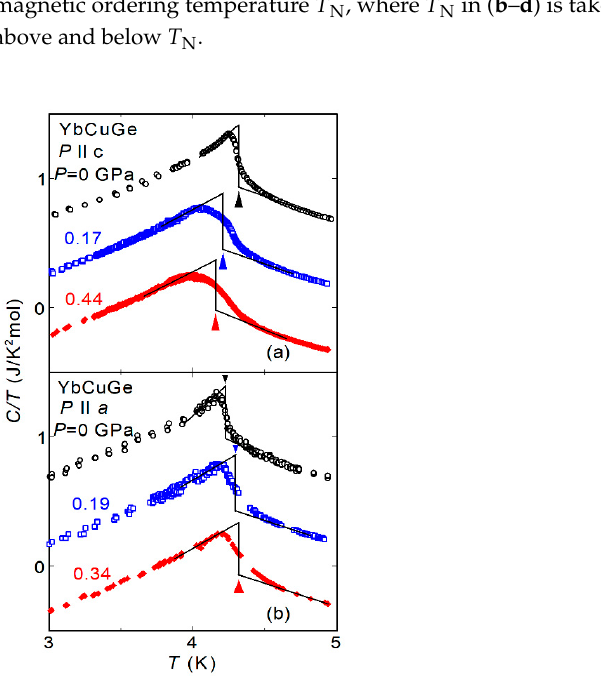
Figure 3. Temperature dependence of the magnetic susceptibility M/B of YbCuGe under hydro ‐ static pressures ( a , b ) and uniaxial pressures ( c , d ). The data at 0.33 GPa are shifted downward by 0.1 × 10 ‐ 2 emu/mol to avoid the overlap with the data for 0 GPa. The arrows indicate the antiferro ‐ magnetic ordering temperature T N , where T N in ( b – d ) is taken as the intersection of the two lines above and below T N .